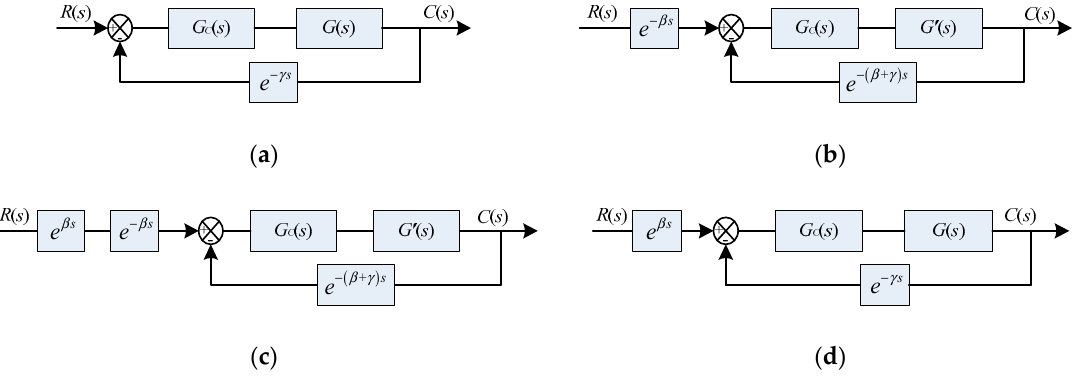
Figure 3. Evolution of autonomous underwater vehicle (AUVs) control system block diagram in this paper. ( a ) AUVs’ block diagram; ( b ) block diagram after separating the lag component and moving the summing junction past the e − β s block; ( c ) block diagram after introducing e − β s component between R ( s ) and the summing junction; and, ( d ) final block diagram after introducing e − β s component.